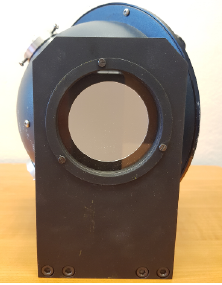
Figure 5. Front view on the integrating sphere exit port covered with the plexiglass. The integrating sphere is mounted in a uni- versal